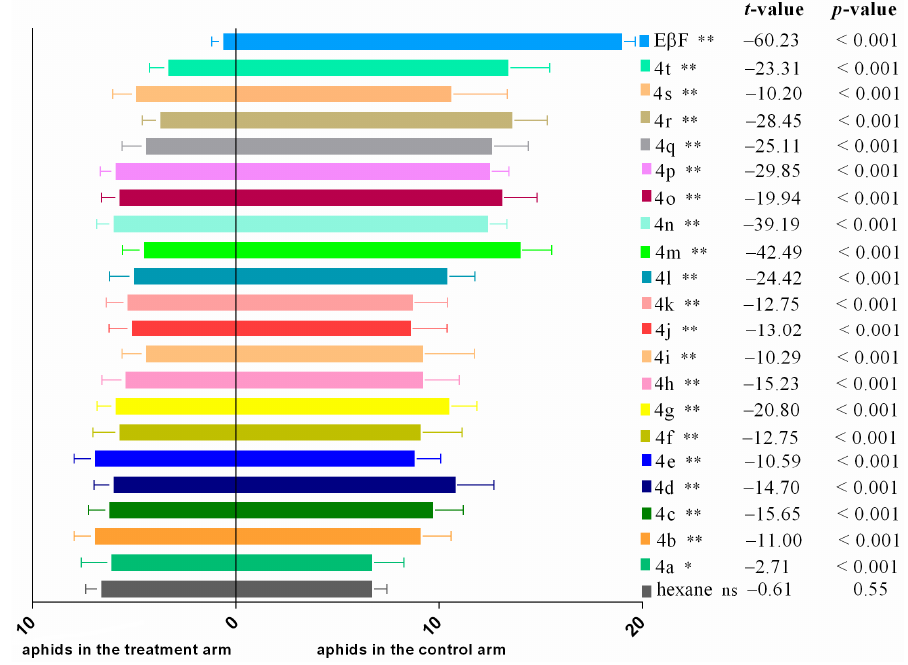
Figure 2. Behavioral response of M. persicae to E β F analogues 4a – 4t . The number of aphids (mean ± standard deviation) in both arms were counted and analyzed by paired t -test. “ns” represents no significance; “*” represents significant difference at p ≤ 0.05 level; and “**” represents significant difference at p ≤ 0.01 level. Table 2. Repellent proportion (RP) of the E β F analogues 4a – 4t against M. persicae .